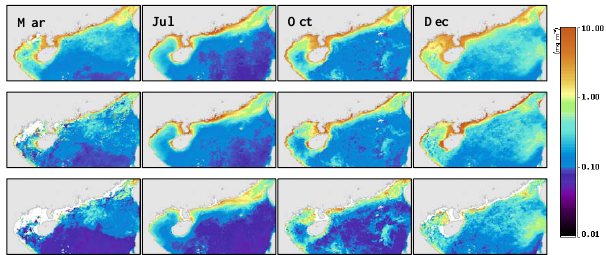
Fig. 3. Climatological monthly mean Chl in the northern South China Sea in March, July, October and December from three algorithms: (top) C_OC3M; (middle) C_GSM; (bottom) C_GIOP.